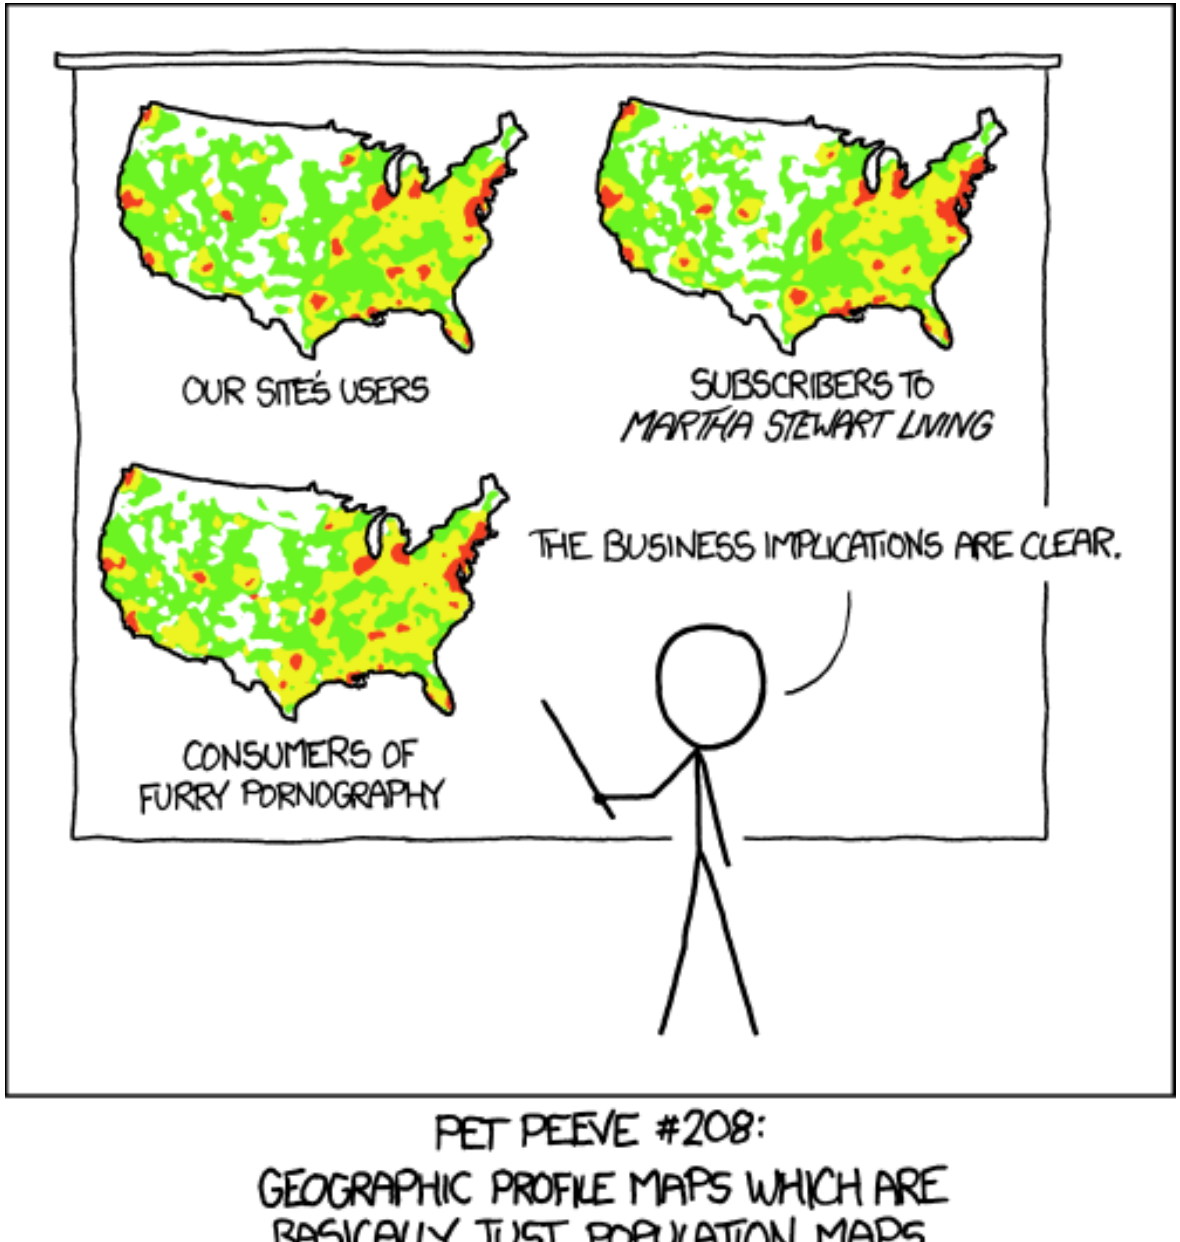
Figure 3. xkcd comic showing an obvious correlation between US population density and an unrelated variable. ( Heatmap ,